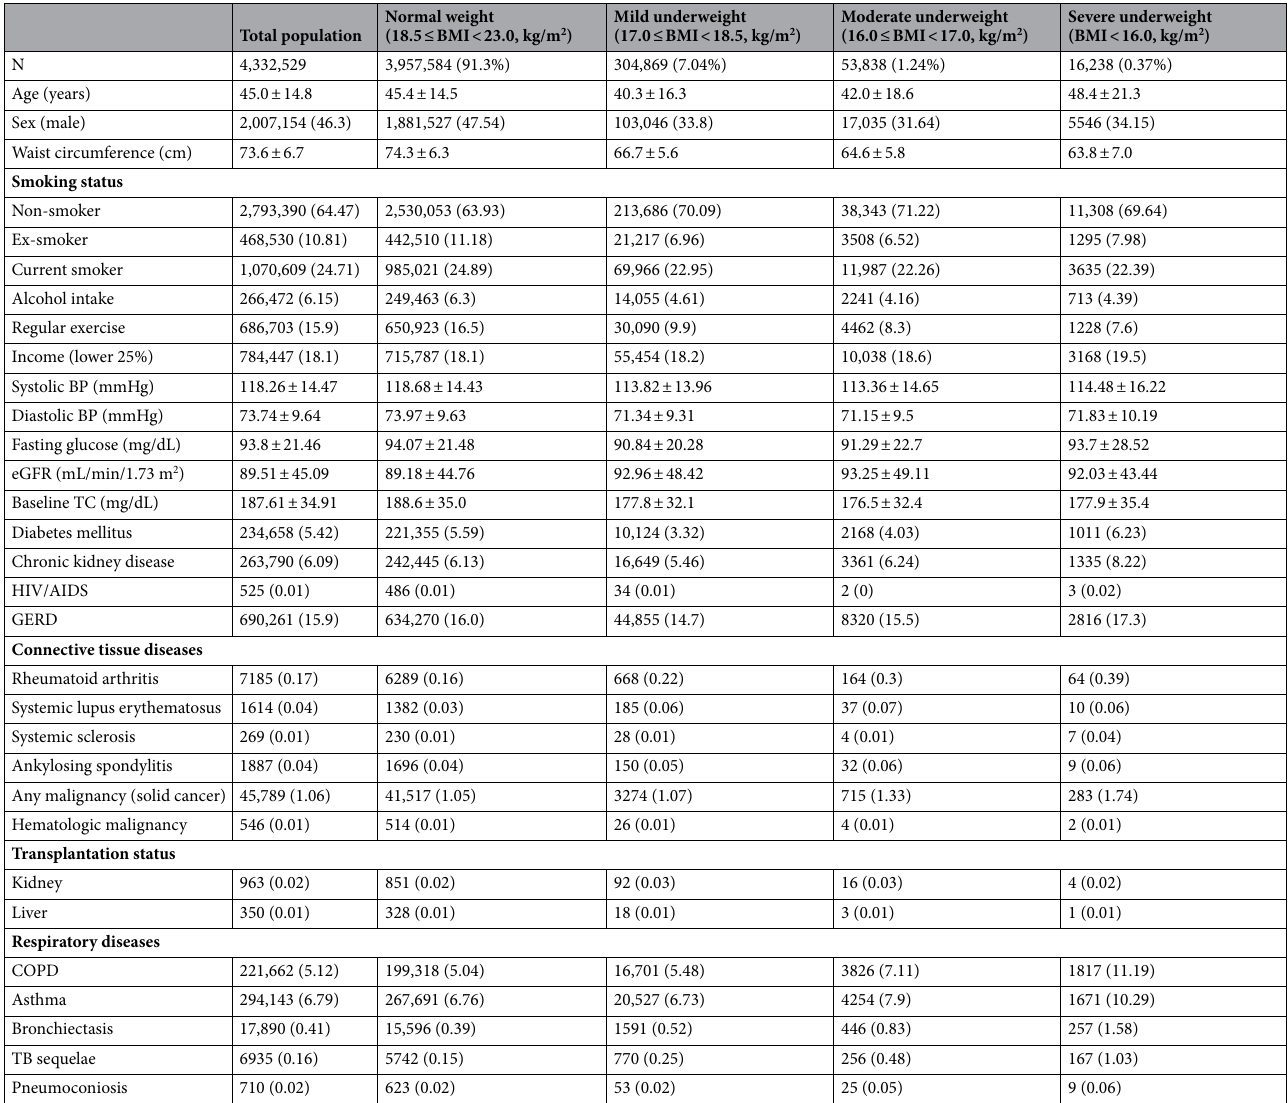
Table 1. Baseline characteristics of subjects according to the baseline body mass index. Data are expressed as the means ± SD, median (25–75%), or n (%). BP blood pressure, eGFR estimated glomerular filtration rate, HDL high-density lipoprotein, LDL low-density lipoprotein, TC total cholesterol, TG triglyceride, HIV human immunodeficiency virus infection, AIDS acquired immune deficiency syndrome, GERD gastroesophageal reflux disease, COPD chronic obstructive pulmonary